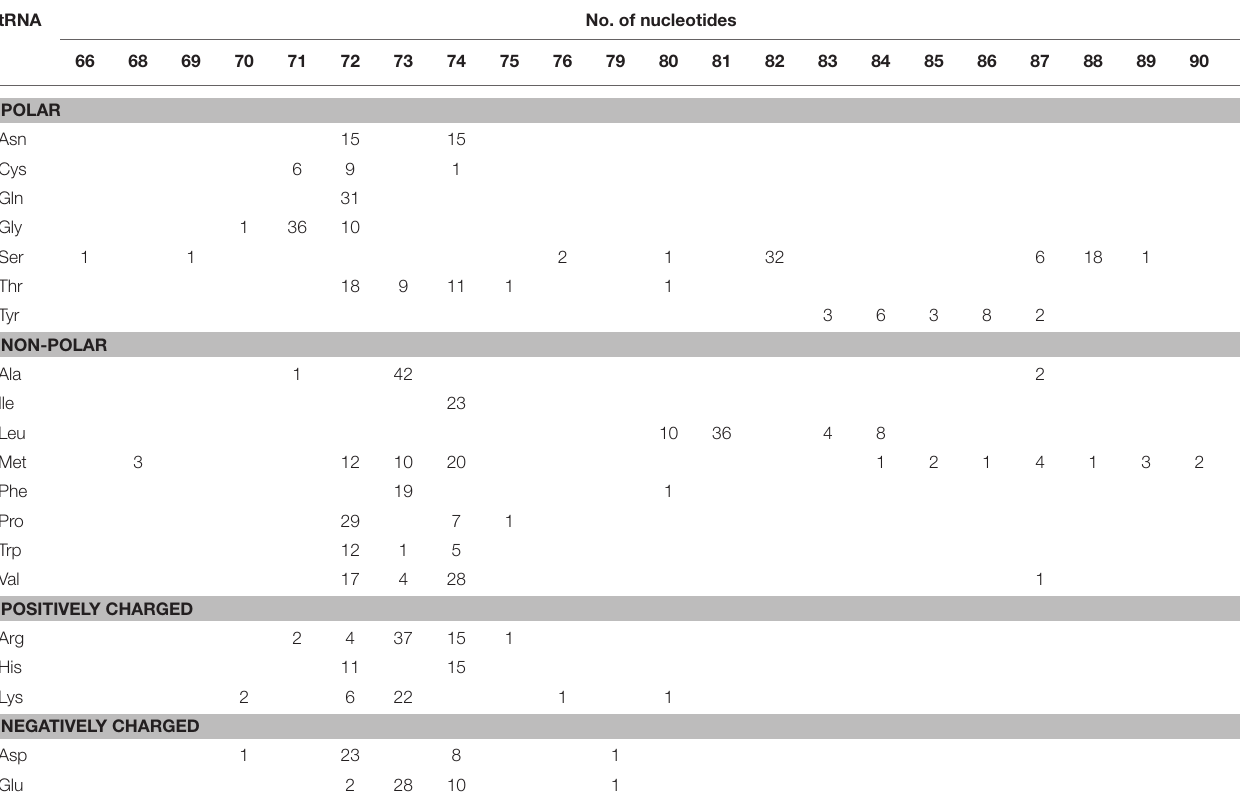
TABLE 3 | Nucleotide length of different tRNAs in O. sativa . tRNA No. of nucleotides